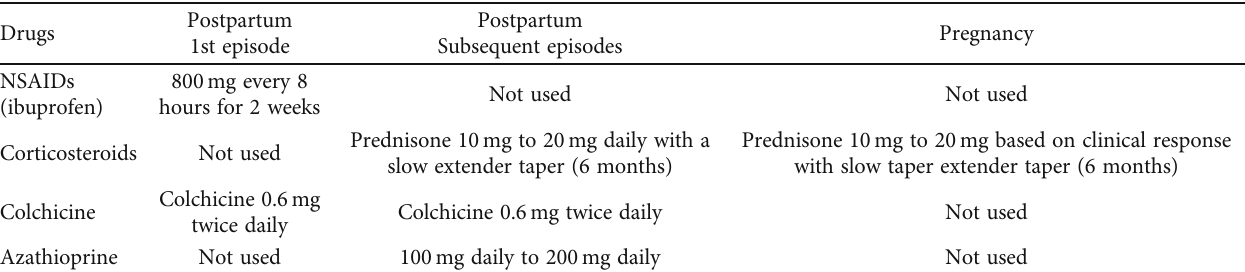
Figure 3: Mild to moderate pericardial e ff usion with minimal respiratory variation. Table 2: Treatment scheme for medical therapy of pericarditis during